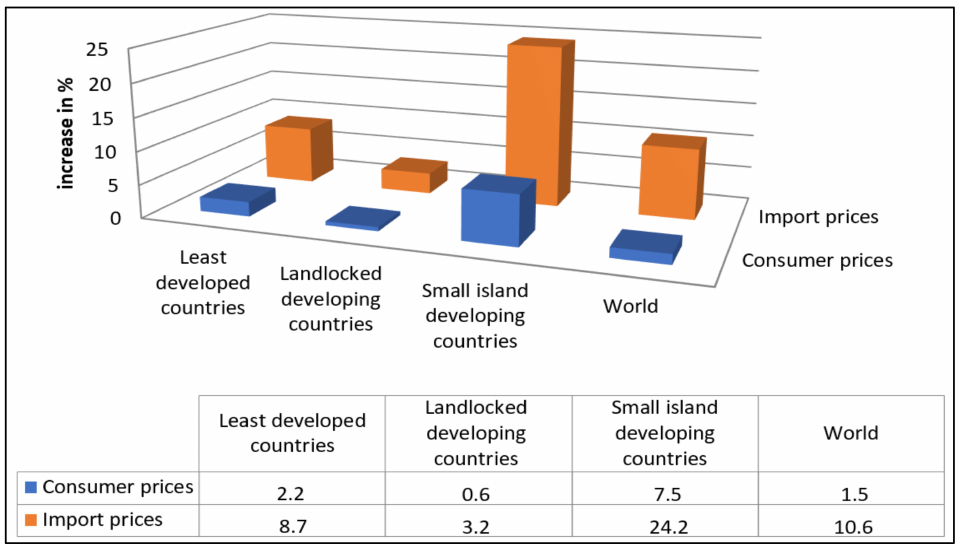
Figure 5. Simulation of the effects of current freight rates on the maritime container market on import and consumer prices. Source: compiled by the author according to